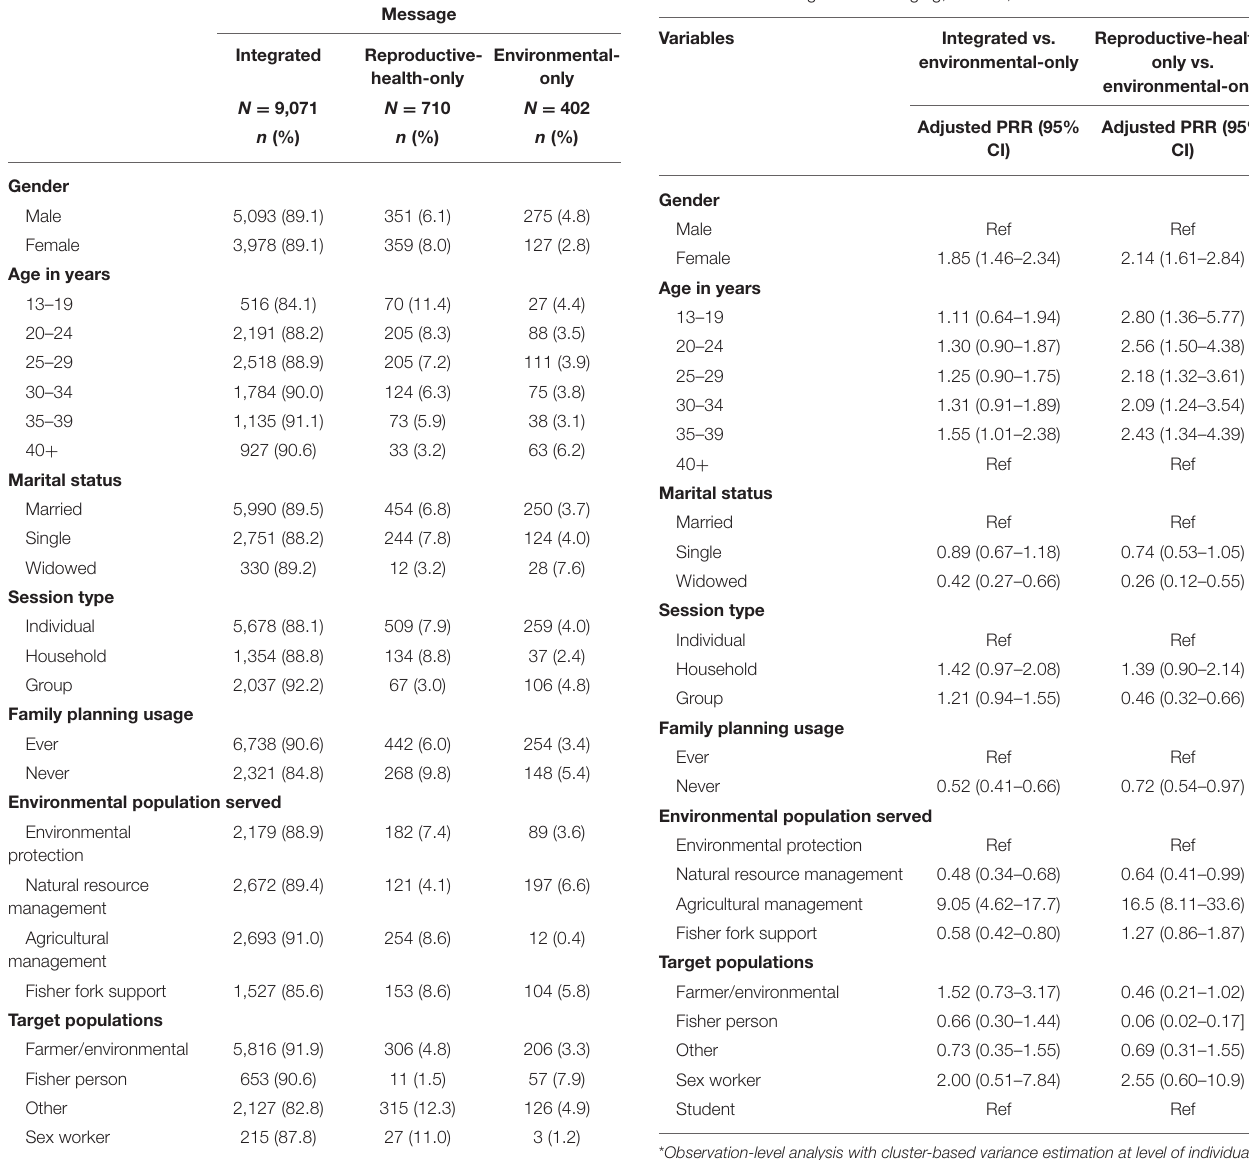
TABLE 5 | Bivariate analysis of integrated messaging, N = 10,183.